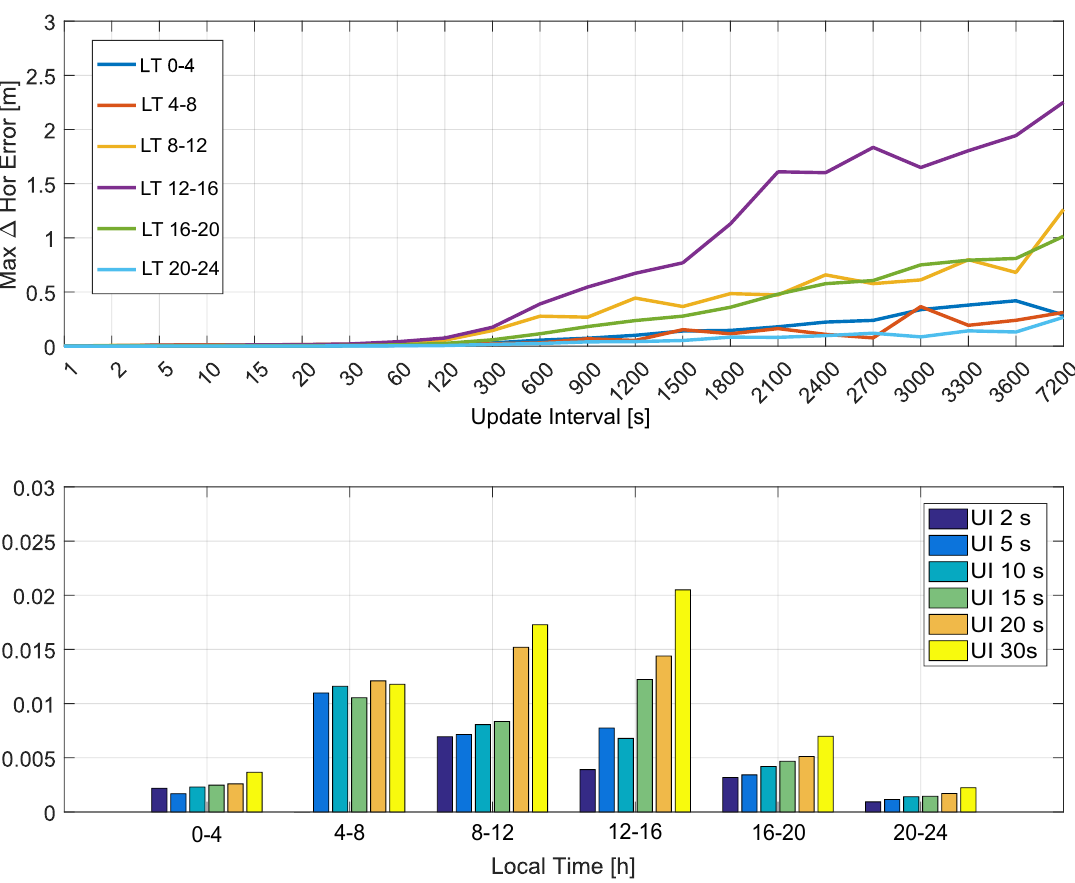
Figure 12. Maximum absolute horizontal position differences as a function of the local time. In the legend, “UI” stands for “Update